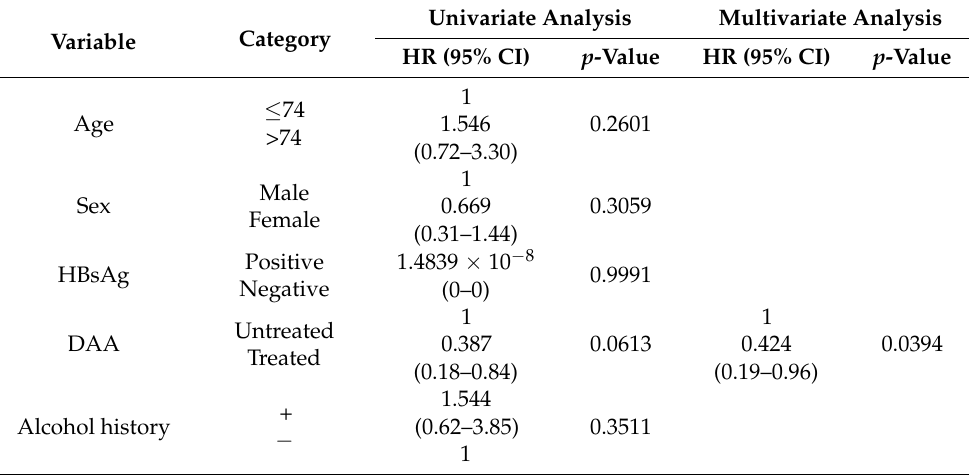
Table 4. Univariate and multivariate analyses of 2nd HCC recurrence-free survival after